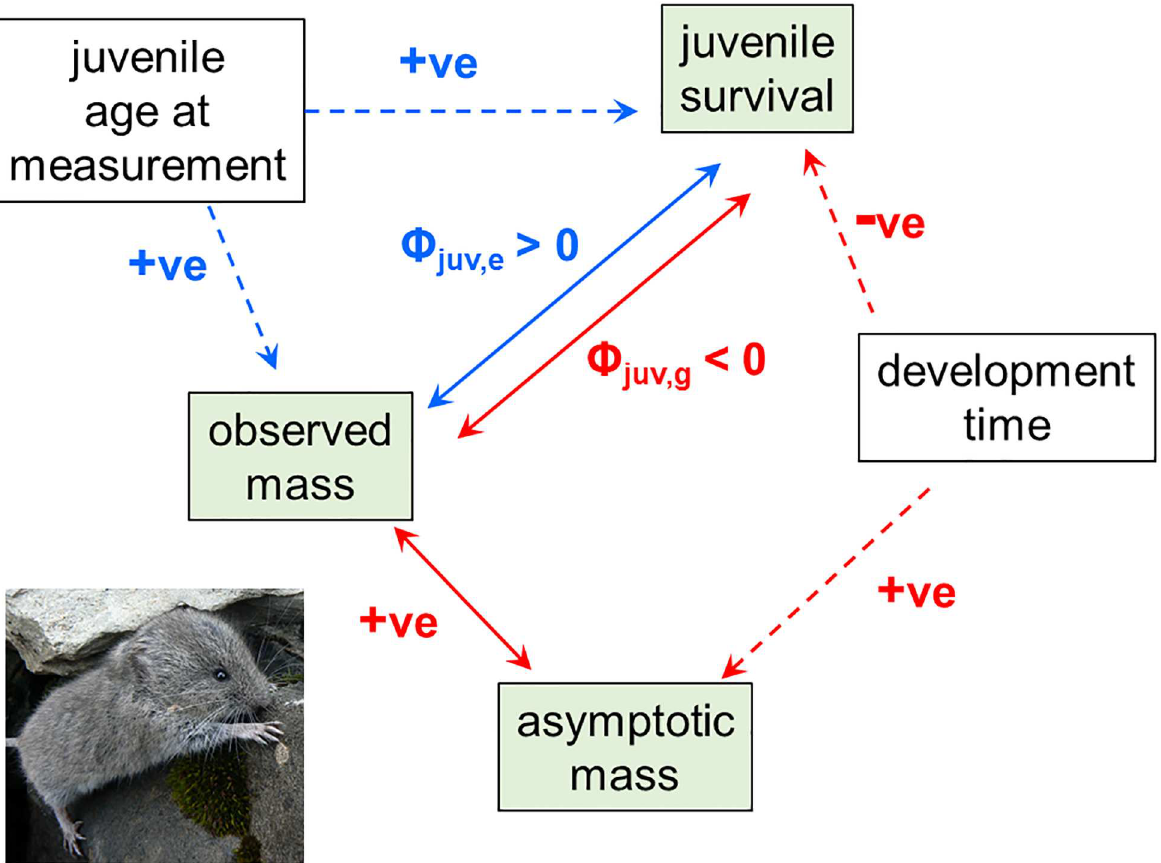
Fig 1. The hypothesised associations between traits and fitness in snow voles. “+ve” denotesa positive relationship;“-ve” denotes the negativerelationshipbetweendevelopment time and juvenilesurvival. Green boxes are traits that have been measuredor (in the case of asymptotic mass) estimated; white boxes are “missing” traits. One-headed arrows imply direct effects; two-headed arrows represent covariance. Blue lines represent entirely nongenetic associations; red lines have some geneticbasis. Solid lines represent estimated parameters; dashedlines represent inferred associations. Fitness is assessedby juvenilesurvival, relative to the population average. Φ juv,e is the nongenetic covariancebetweenjuvenilesurvival and observedmass; Φ juv,g is the additivegenetic covariance(see Figure 3 in Bonnet et al. [1] for values). Photo copyright T. Bonnet.